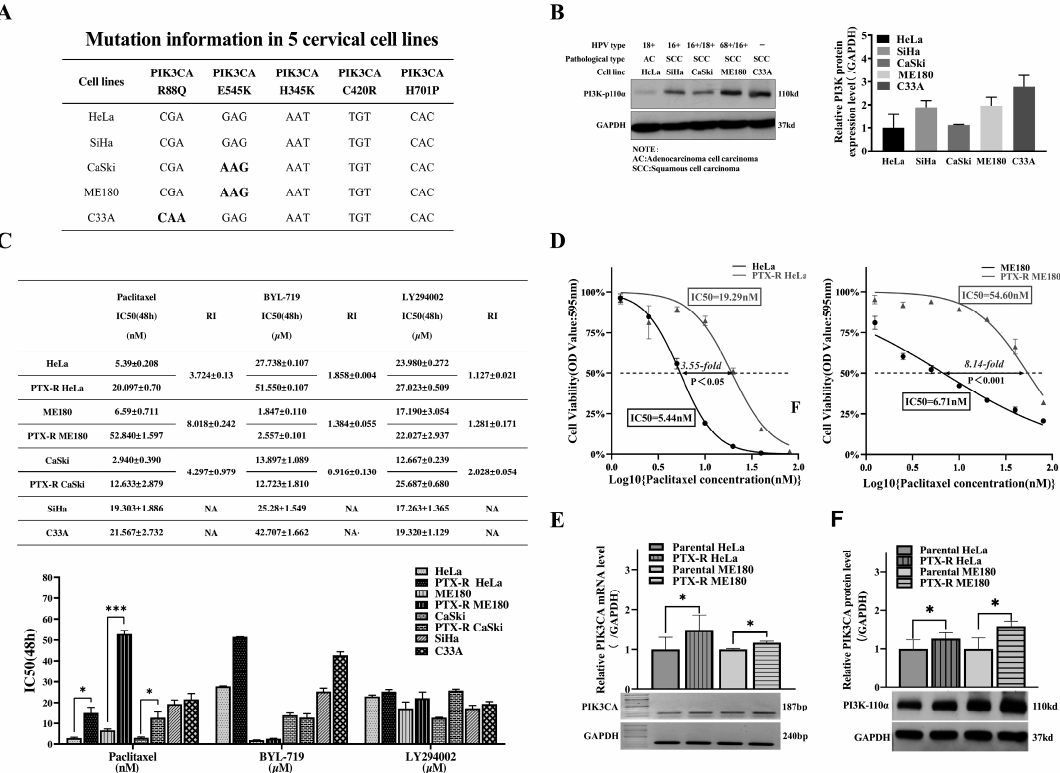
Figure 2. PIK3CA mutational status, expression in cervical cell lines, and its alterations and chemo- sensitivity to paclitaxel and BYL-719 or LY294002 after the induction of paclitaxel-resistant cells. ( A ) Hotspot mutation analysis for PIK3CA is summarized in a panel of human cervical cancer cell lines based on The Cancer Cell Line Encyclopedia (CCLE) project. ( B ) The protein expression of PIK3CA in five common cervical cancer cell lines, with or without high-risk human papilloma virus (HPV)-type infections, that were initiated from di ff erent pathological types were studied by western blot assay. The representative bands are shown on the left. ( C ) The half-maximal inhibitory concentration (IC50) values for paclitaxel, BYL-719, and LY294002 were calculated for five cervical cancer cell lines as well as three paired paclitaxel-resistant cell lines after 48 h. * p < 0.05, ** p < 0.01. *** p < 0.01. ( D )